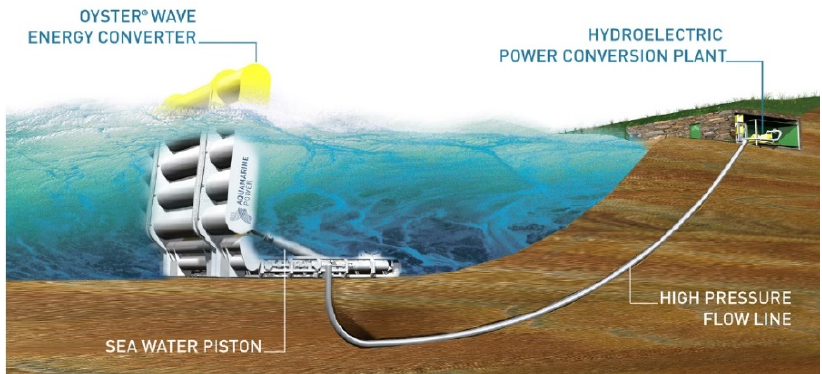
Figure 25. Working principle of Oyster [86,87].